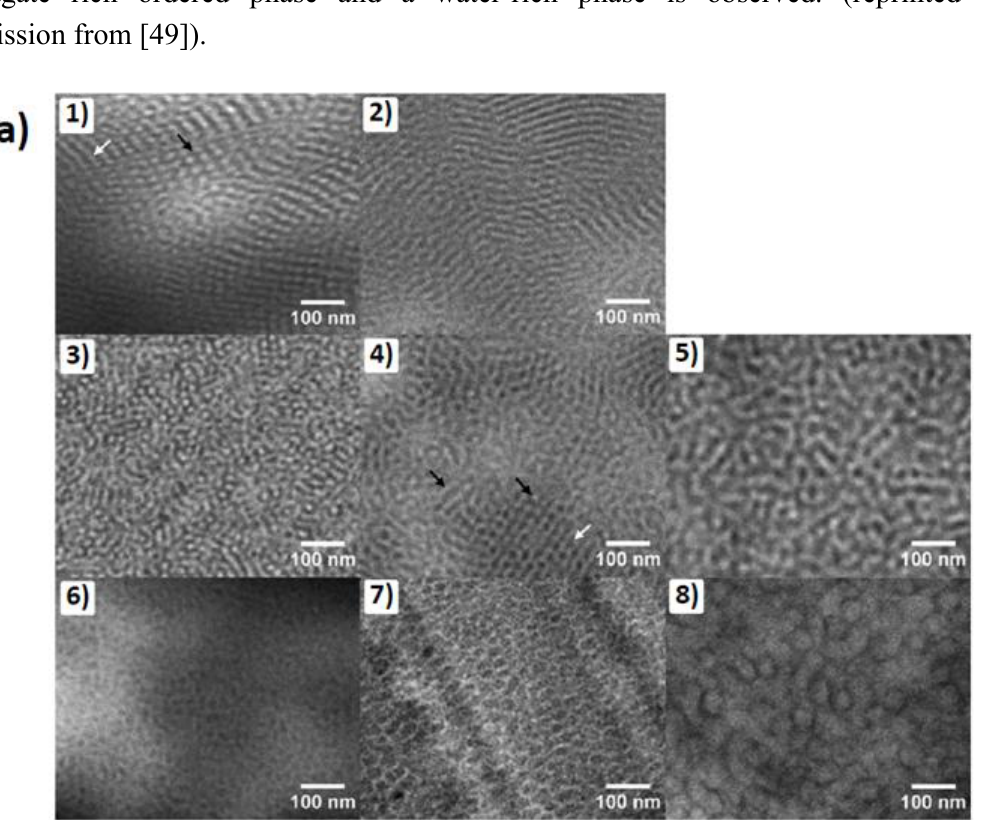
Figure 4. ( a ) TEM images for as-cast m Cherry-PNIPAM block copolymers. (1) Cylinders cast from a polymer-selective solvent. The white arrow shows an example of cylinders parallel to the field of view, and the black arrow points out perpendicular